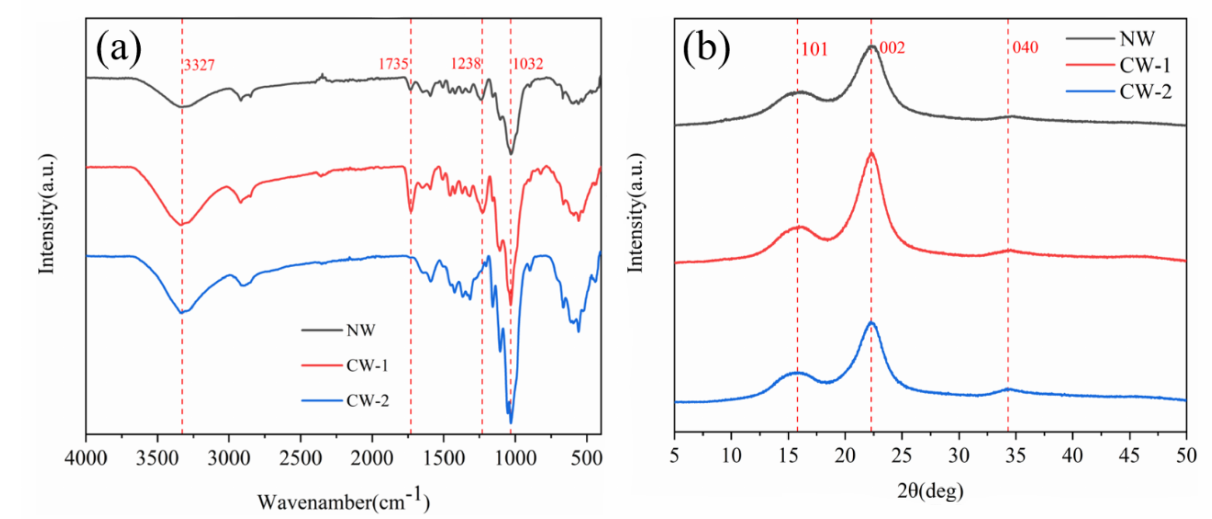
Figure 4. ( a ) FT-IR spectra of NW and CW. ( b ) XRD patterns of NW and